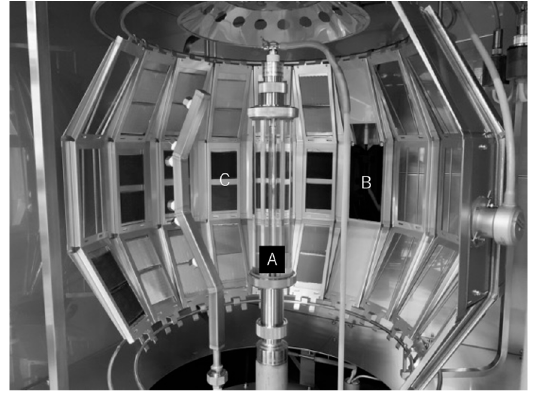
Figure 2. Test specimen placement in the test frame.